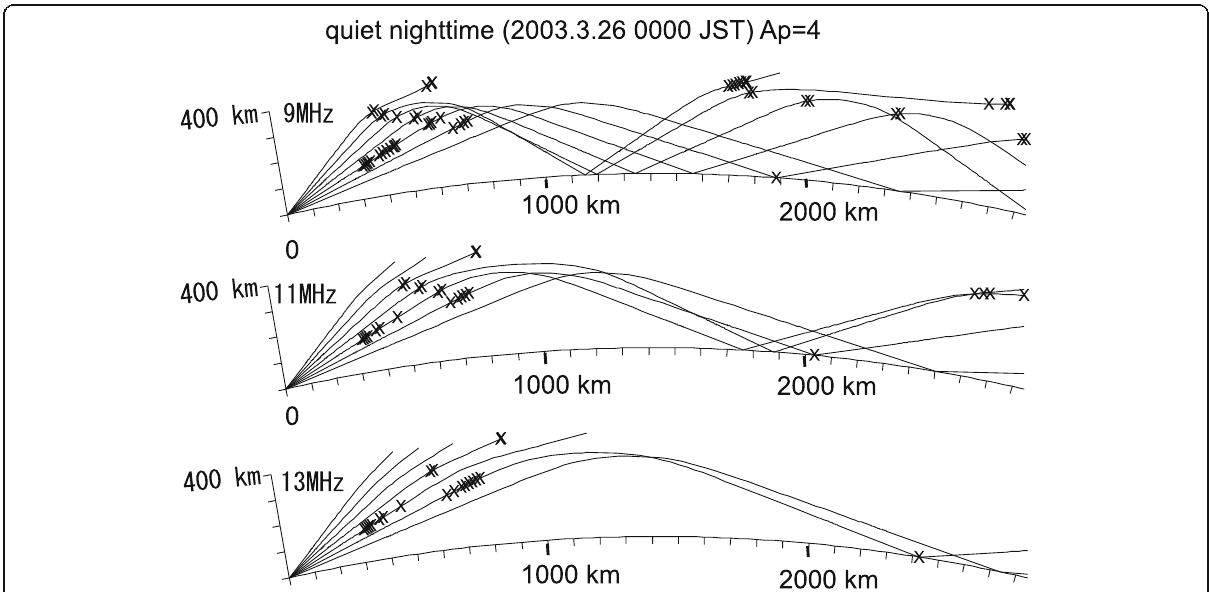
Fig. 26 Ray-tracing analysis (solid curves) and expected locations for ionospheric irregularity backscatter occurrence (asterisks) for HOK during nighttime quiet geomagnetic conditions and transmission frequencies of (top to bottom) 9, 11, and 13 MHz, respectively. Adapted from Fig. 3 of Nishitani and Ogawa